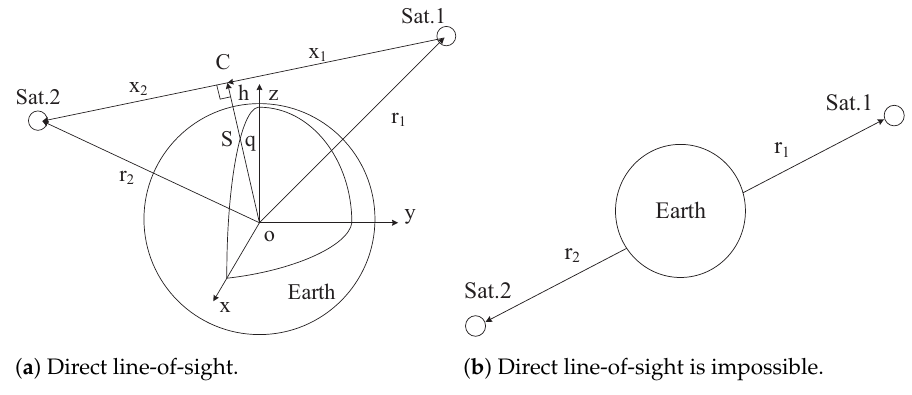
Figure 5. Geometry of two satellites in the case of direct